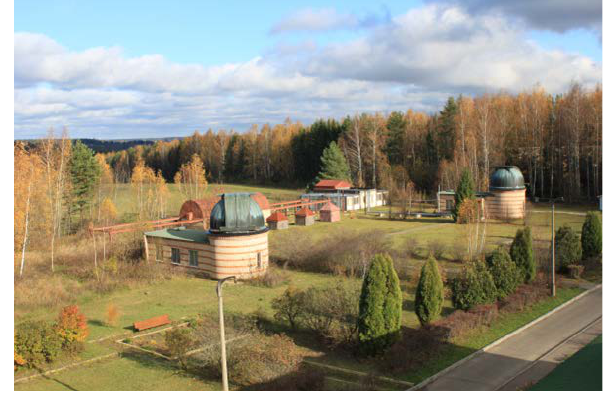
Figure 3. The Zvenigorod